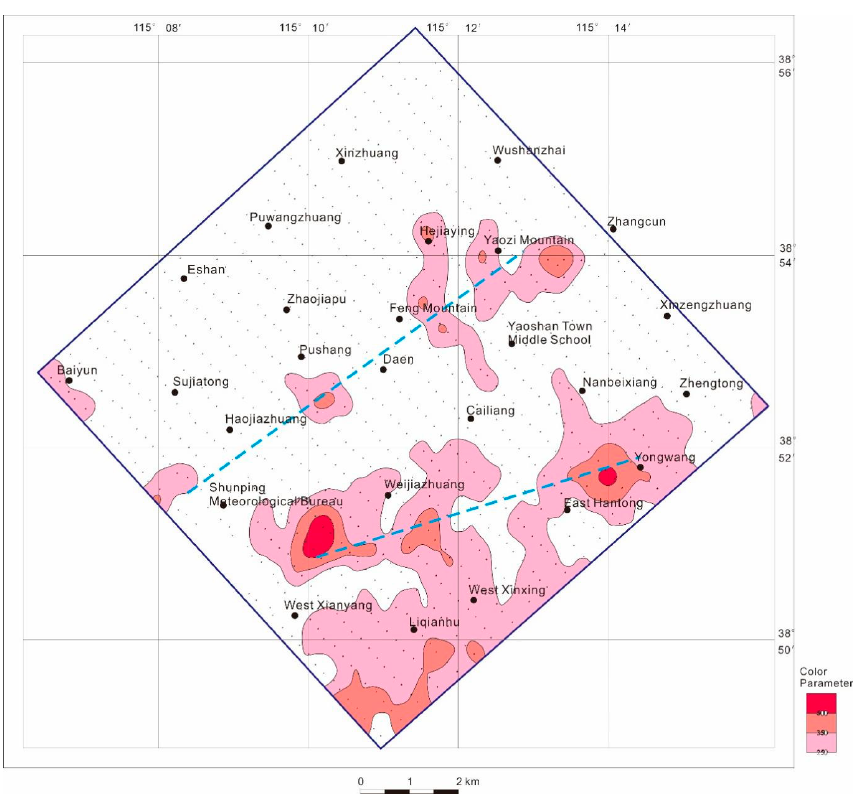
Figure 9. Abnormal distribution of Rn in soil.